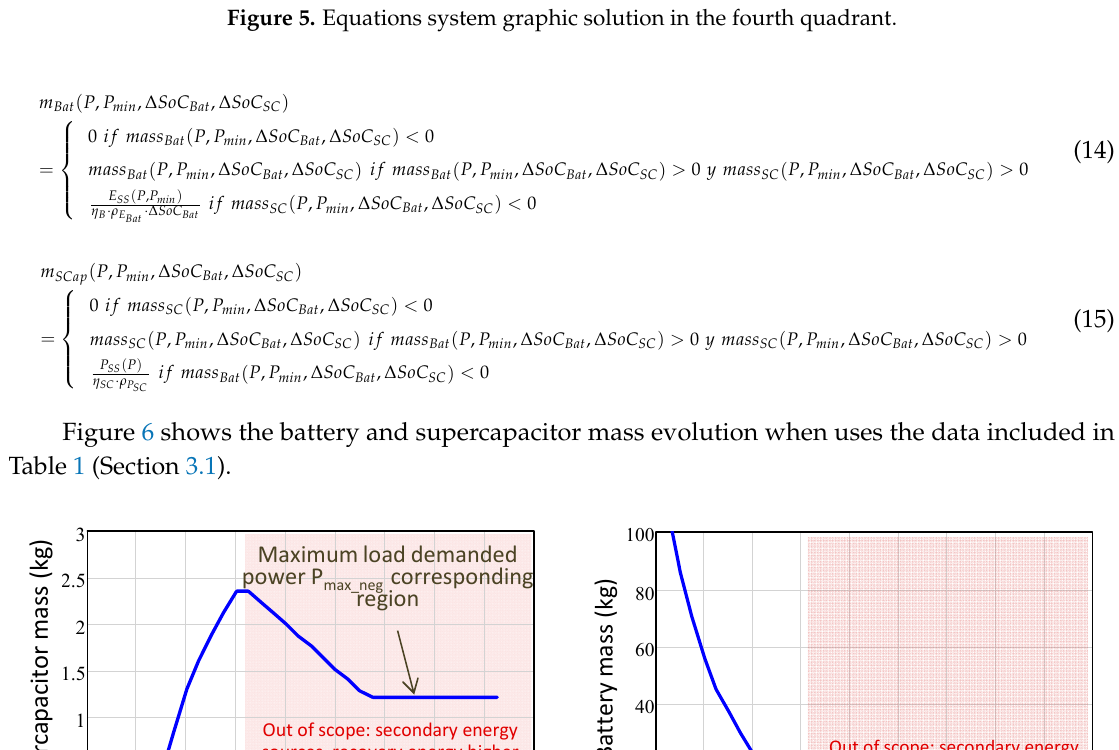
Figure 6. Equations system graphic solution in the first quadrant.